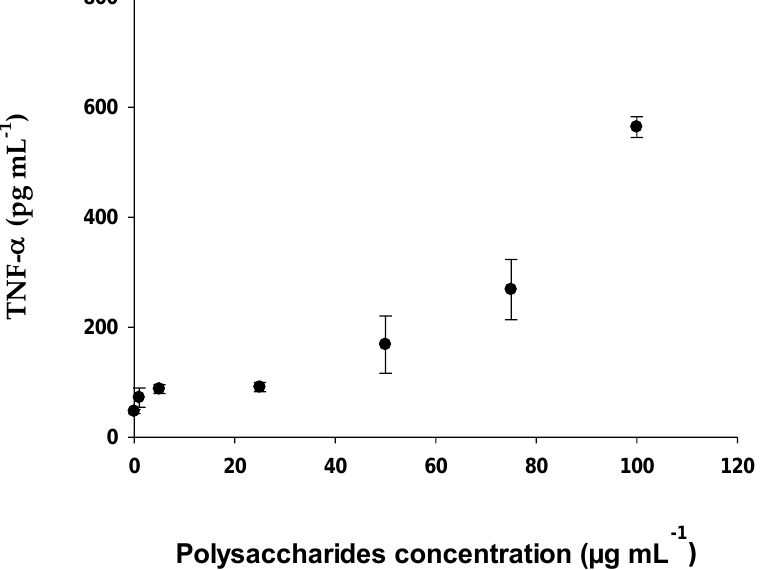
Figure 9. Concentration of Tumor Necrosis Factor- α by RAW 264.7 macrophages exposed to different concentrations of EgPs. Data points represent the average of three samples ± SD.